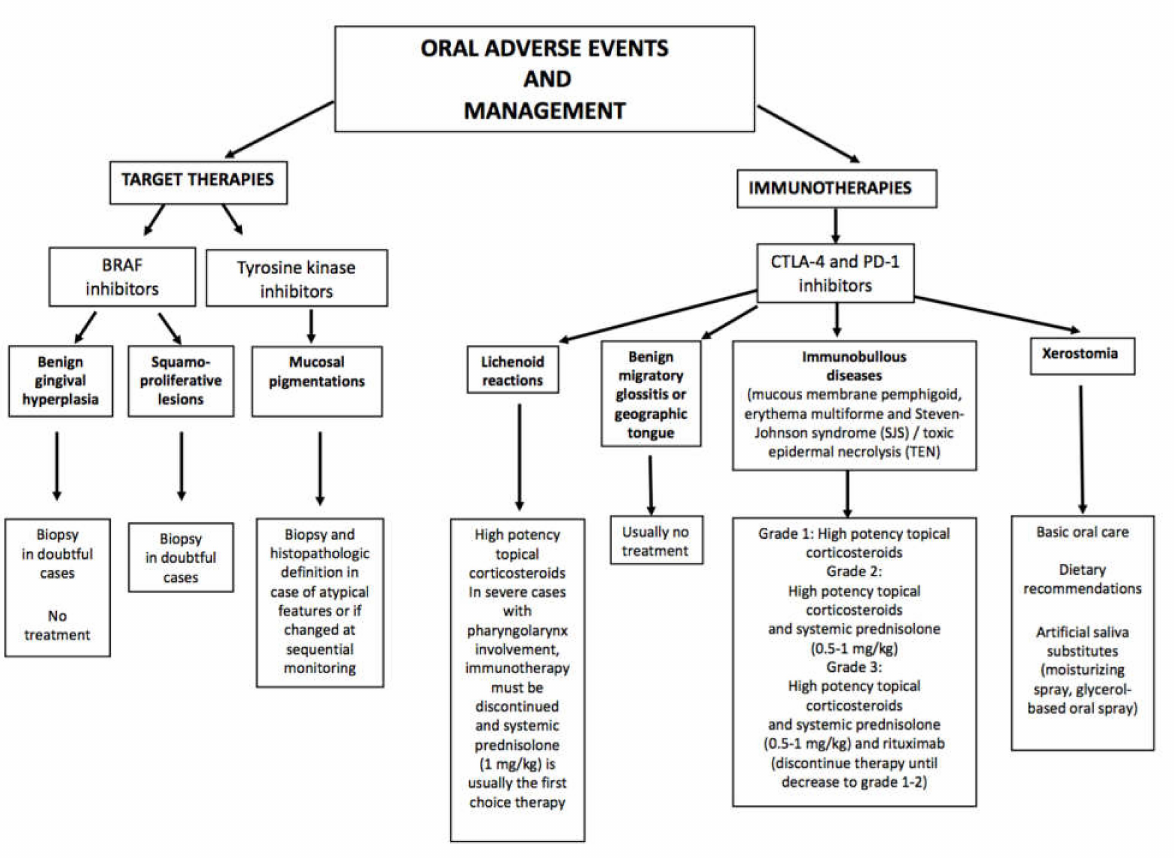
Figure 1. Oral adverse events and their management occurring during the treatment with target therapies (BRAF inhibitors and tyrosine kinase inhibitors) and immunotherapies (CTLA-4 and PD-1 inhibitors). BRAF (v-raf murine sarcoma viral oncogene homolog B1); CTLA-4 (checkpoints T-lymphocyte-associated protein 4); PD-1 (programmed cell death protein